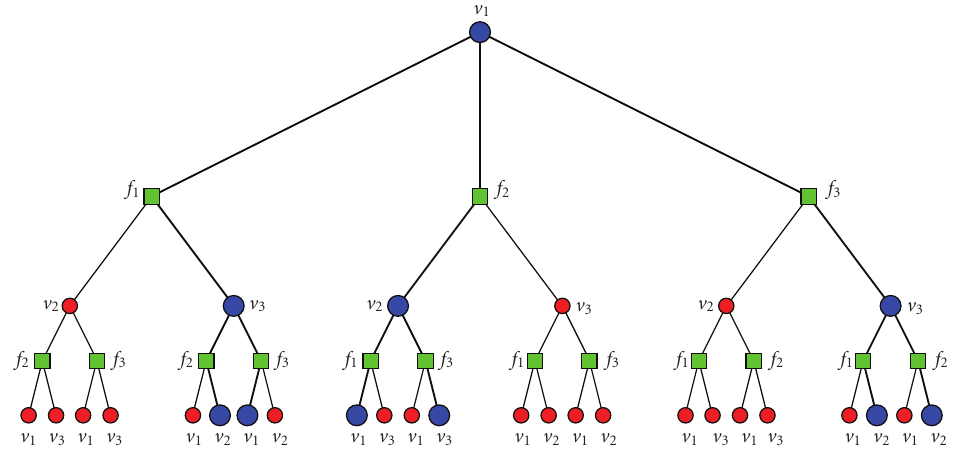
Figure 6: Example of a deviation on the computation